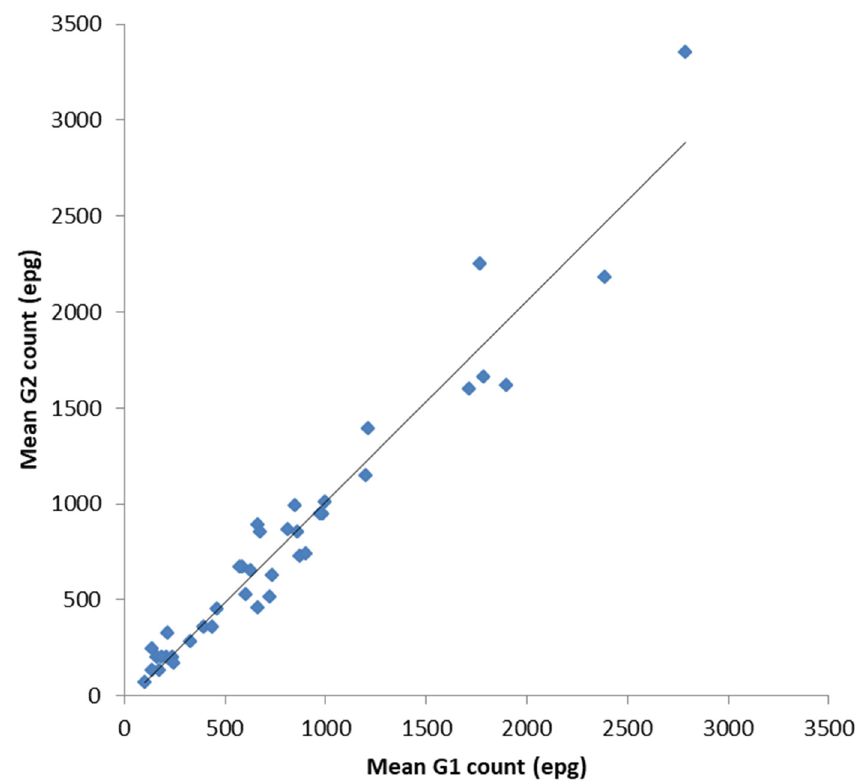
Figure 3. Comparison between the mean G1 and mean G2 counts for each equine faecal sample. The data analysis demonstrates a strong positive correlation between both the established G1 method and the novel G2 method for equid faecal egg counts. The mean percentage accuracy (mean G2 count as a percentage of the mean G1 count, ± SE) was determined at 101 ± 4%. Table 1. Repeatability of methods of equine faecal egg counting using the FECPAK G1 and FECPAK G2 . A repeated measures ANOVA (rmANOVA) was used to test the repeatability of the G1 and G2 methods on the faecal egg count (FEC) replicates of individual equine samples. The analysis demonstrates no differences between the repeated samples meaning that average FEC for each individual could be used to compare the G1 and G2 methods.